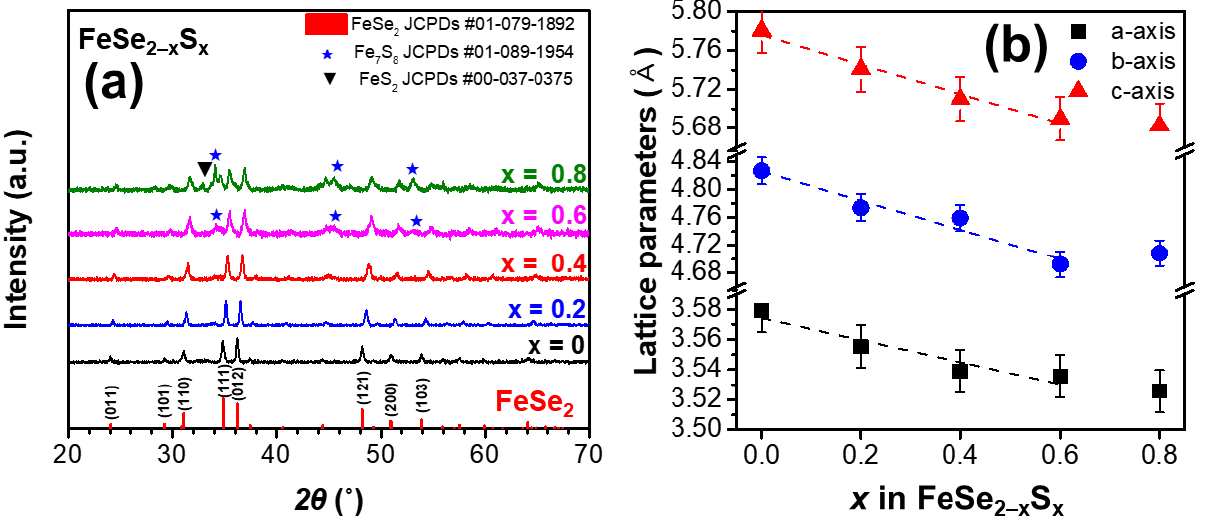
Figure 1. ( a ) XRD patterns of the series of FeSe 2− x S x ( x = 0, 0.2, 0.4, 0.6, 0.8, and 1) samples. ( b ) Lattice parameters calculated using the XRD patterns.